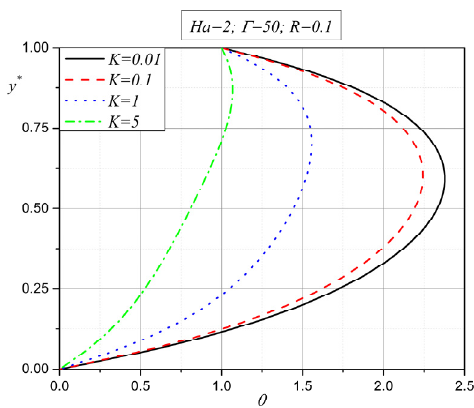
Figure 7. Dimensionless temperature θ in function of coupling parameter K .